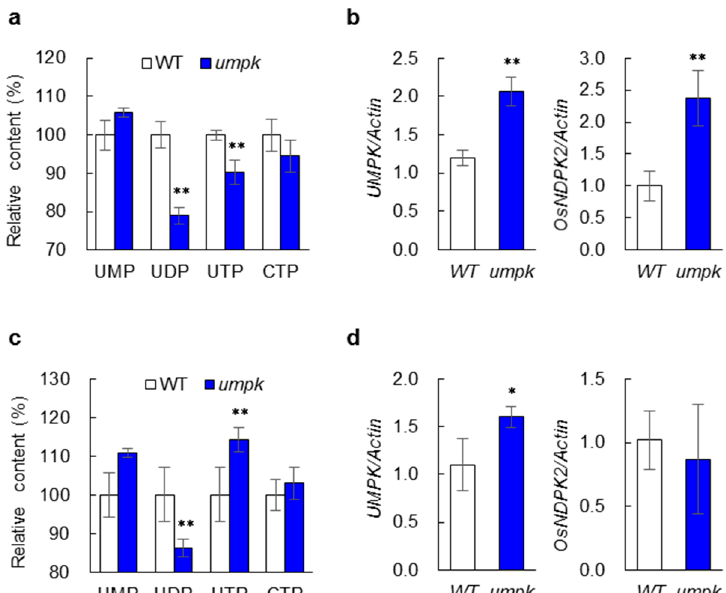
Figure 2. Pyrimidine metabolism analysis in the WT and the umpk mutant. ( a ) Pyrimidine nucleotides levels in the youngest fully expanded leaves. ( b ) Expression of two genes involved in pyrimidine metabolism in the youngest fully expanded leaves. Actin1 was used as the internal control. ( c ) Pyrimidine nucleotides levels in old leaves. ( d ) Expression of two genes involved in pyrimidine metabolism in old leaves. Actin1 was used as the internal control. Data represent means ± sd ( n = 3). Significant differences are according to the Student’s t -test at * p < 0.05 and ** p < 0.01.